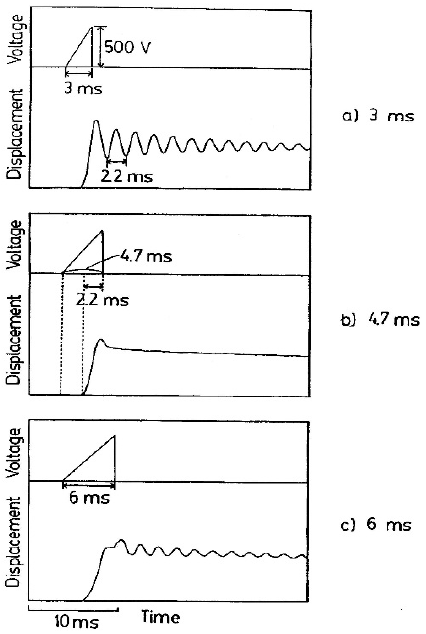
Figure 20. Dynamical response of the tip displacement of the shape memory unimorph with y = 0.063 under various drive pulse conditions for the rise time of ( a ) 3 ms, ( b ) 4.7 ms, ( c ) 6 ms.